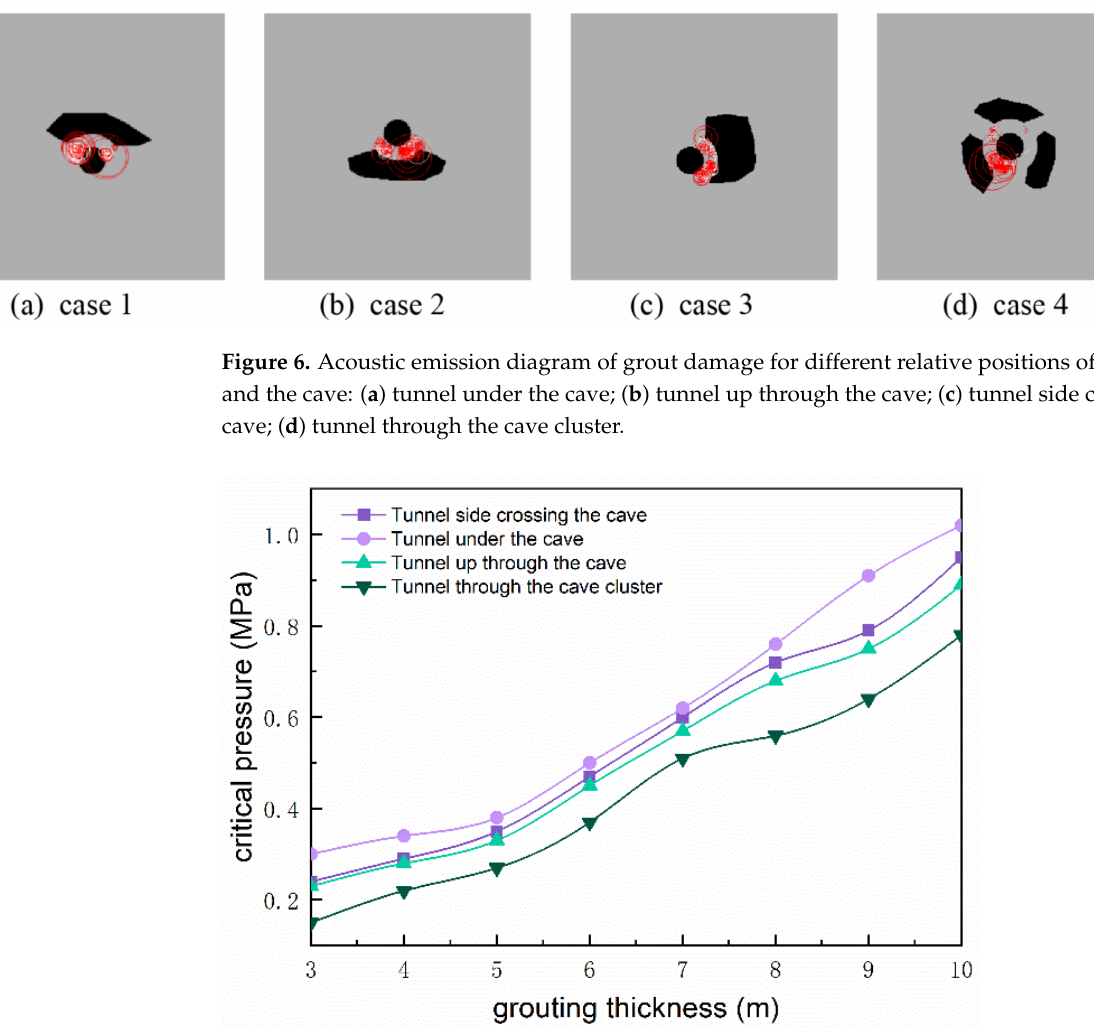
Figure 7. Comparison of water pressure resistance of grouted stone bodies under different relative positions of the tunnel and the cave.